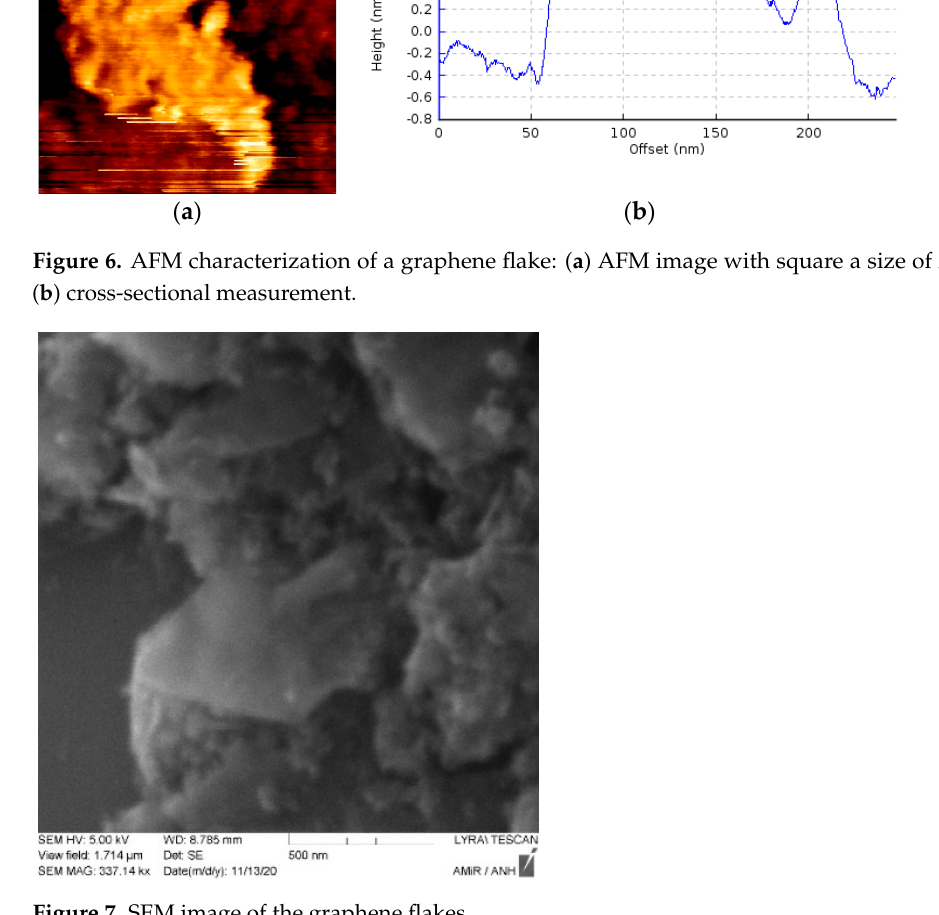
Figure 7. SEM image of the graphene